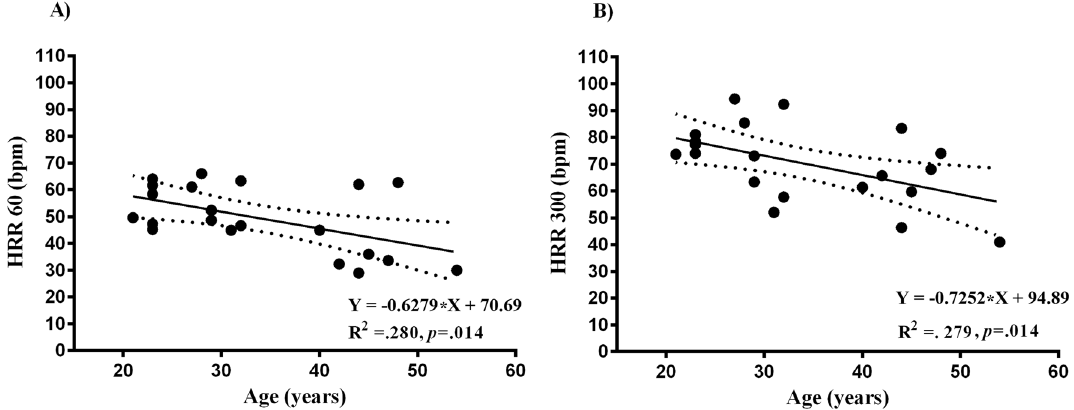
Figure 4. Multiple regression analysis of the HR recovery parameters. Heart rate recovery readings measured after ( A ) 60, and ( B ) 300 s versus the age of the participants